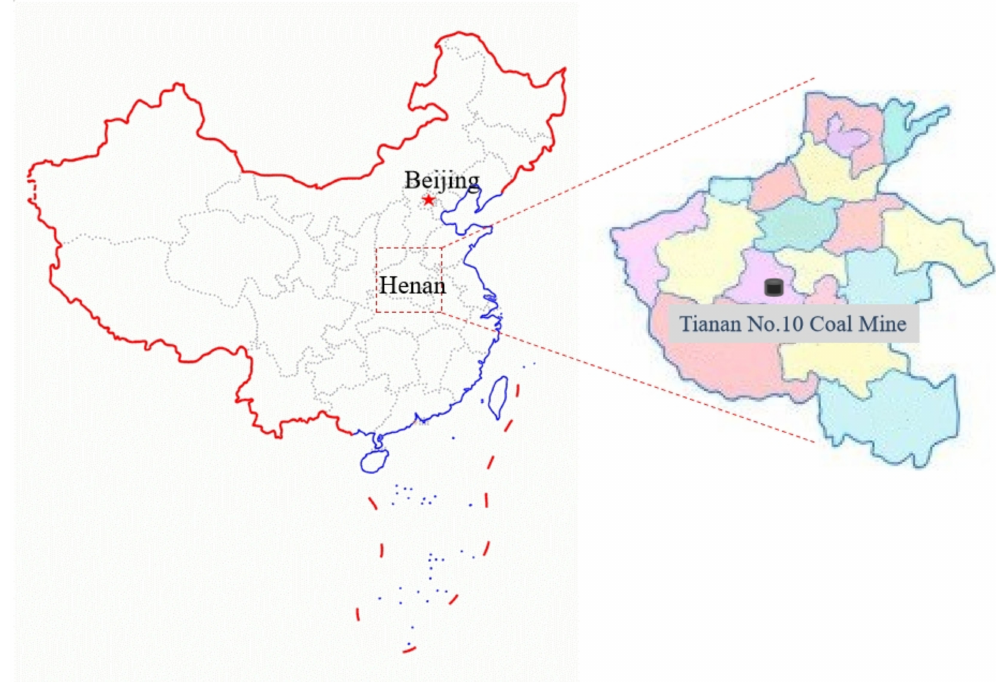
Figure 5. Location of No. 10 mining shares.